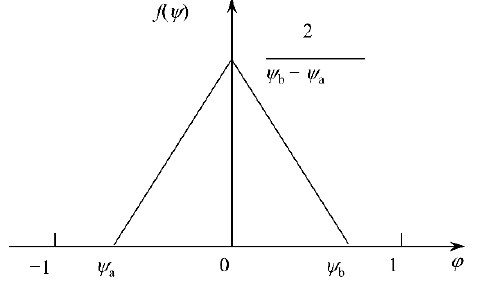
Figure 6. The probability density function of the triangular distribution.